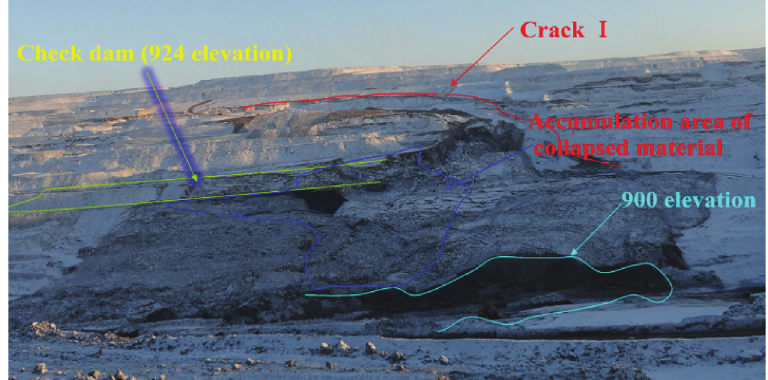
Figure 19: Overall outline of the landslide at the end of 2012.